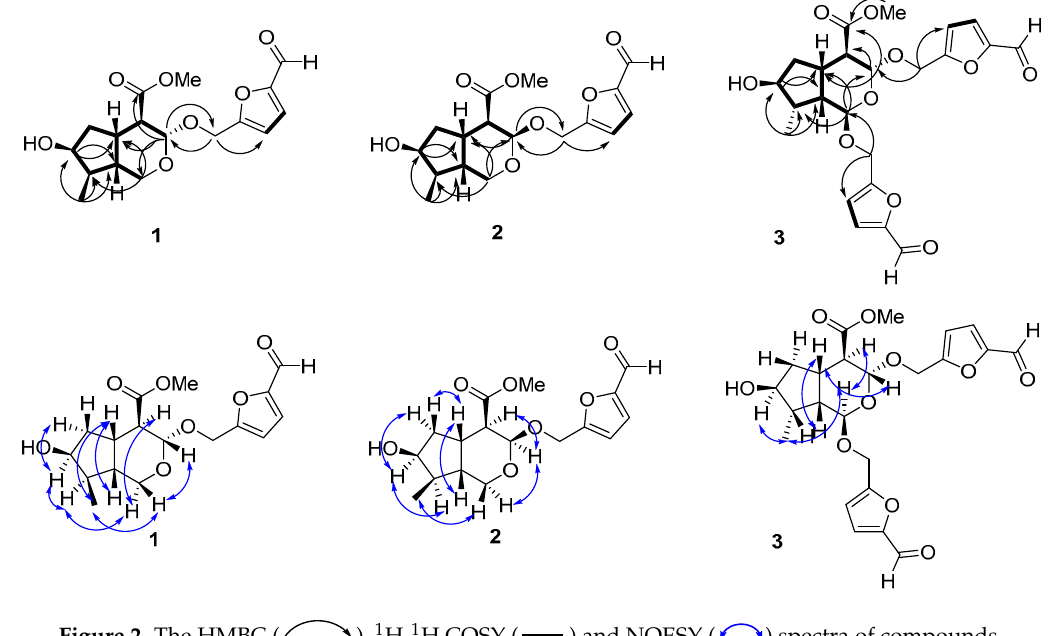
Figure 2. The HMBC ( ) spectra of compounds.